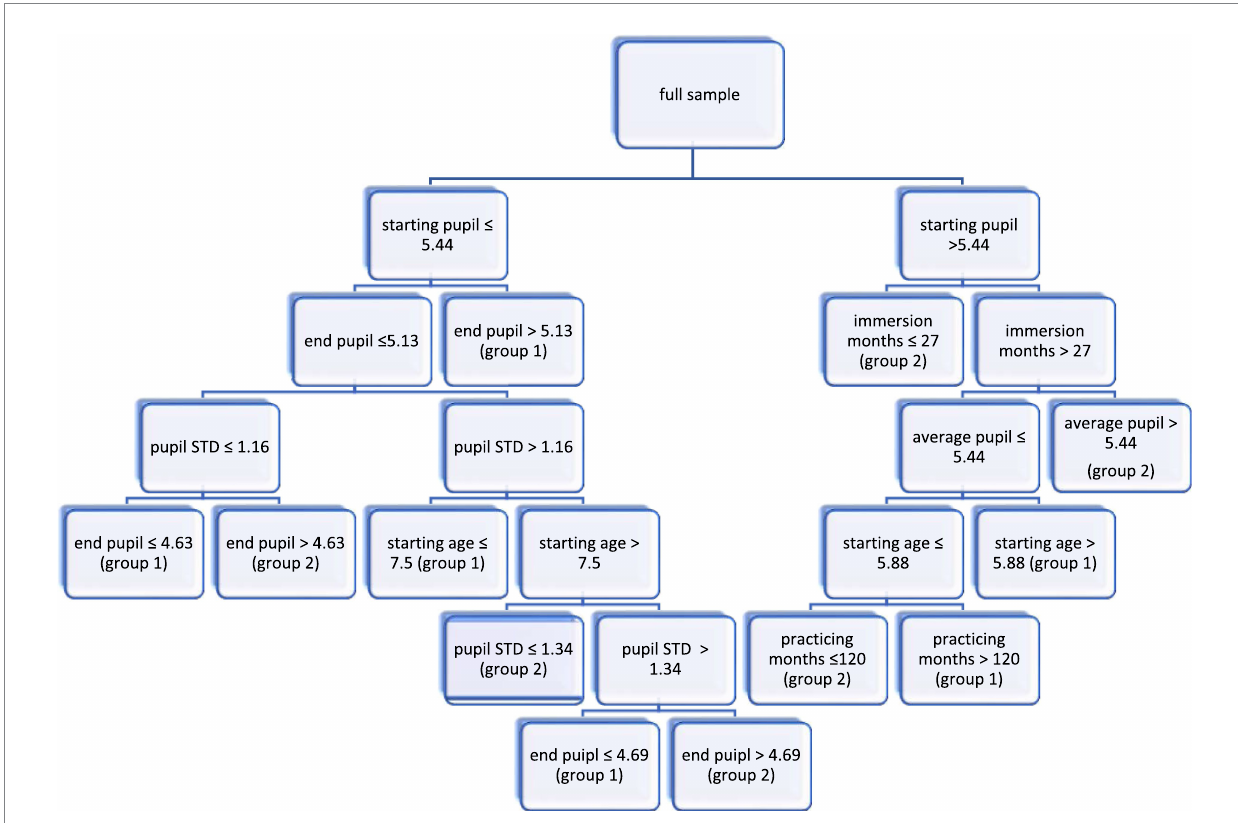
FIGURE 1 Visualization of the prediction model. group 1 = L1 translation and group 2 = L2